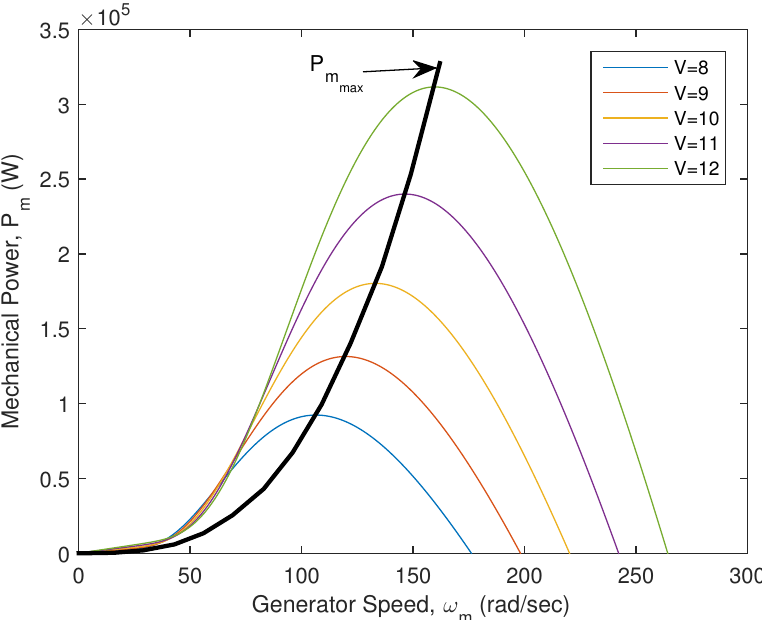
Figure 3. The mechanical power P m versus the generator speed ω m for several values of the wind speed V